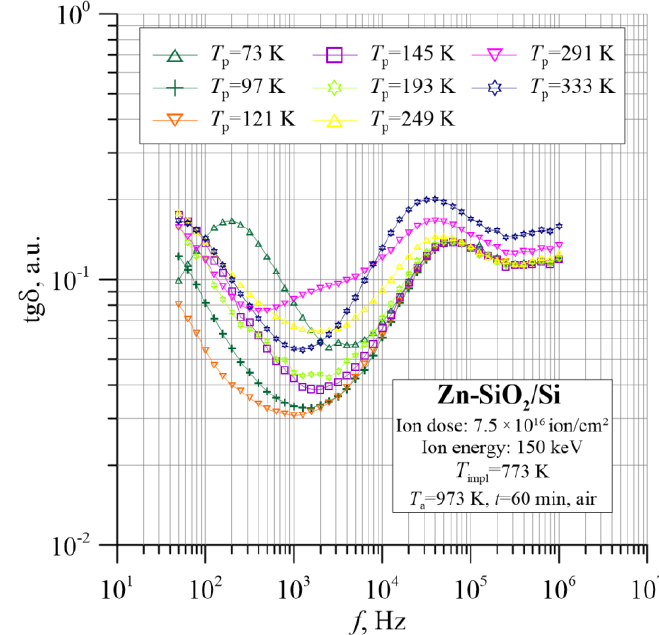
Figure 12. Temperature – frequency dependence of the tangent of dielectric loss angle tg δ ( f , T p ) for the Zn-SiO 2 /Si nanocomposite prepared under “ hot ” implantation conditions (150 keV, 7.5 × 10 16 ion/cm 2 , T impl = 773 K) after annealing.